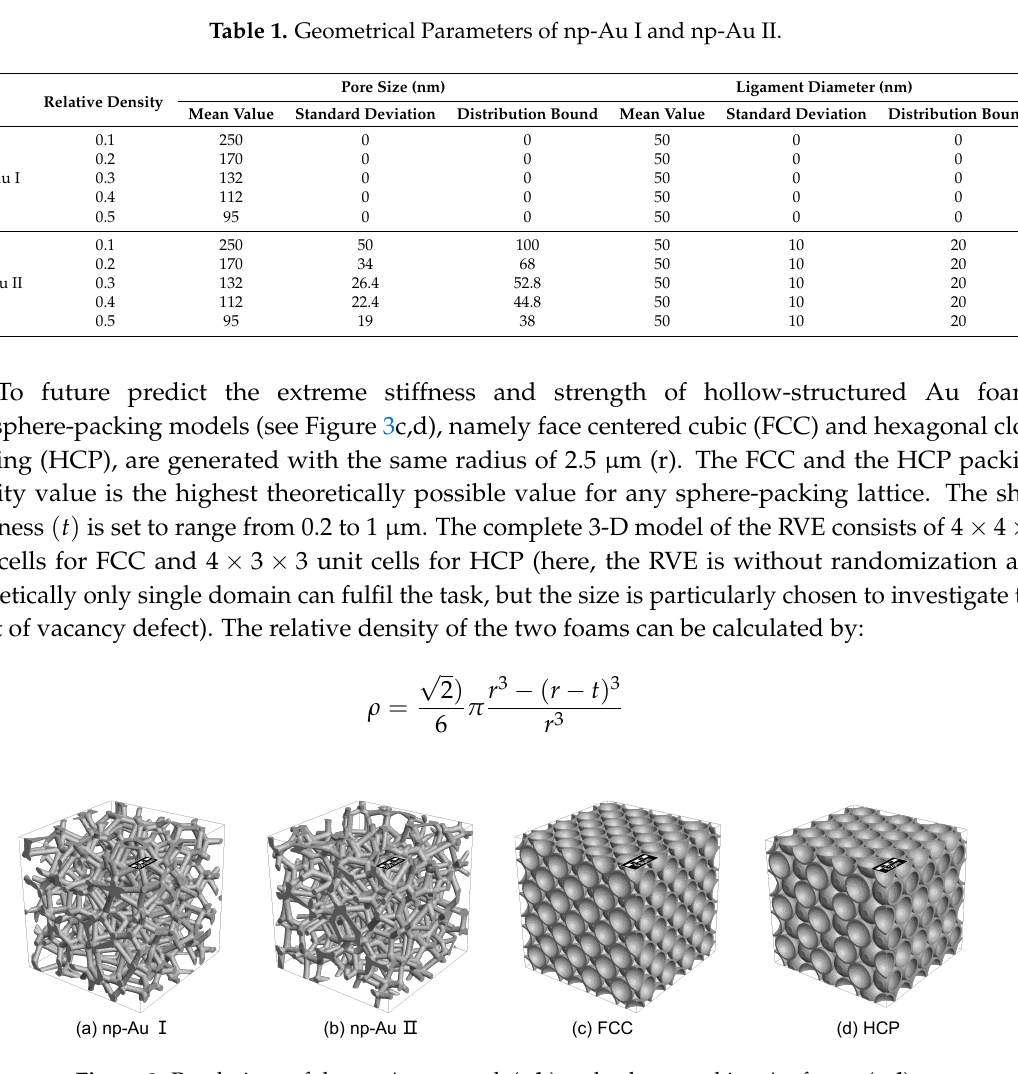
Figure 3. Renderings of the np-Au network ( a , b ) and sphere-packing Au foams ( c , d